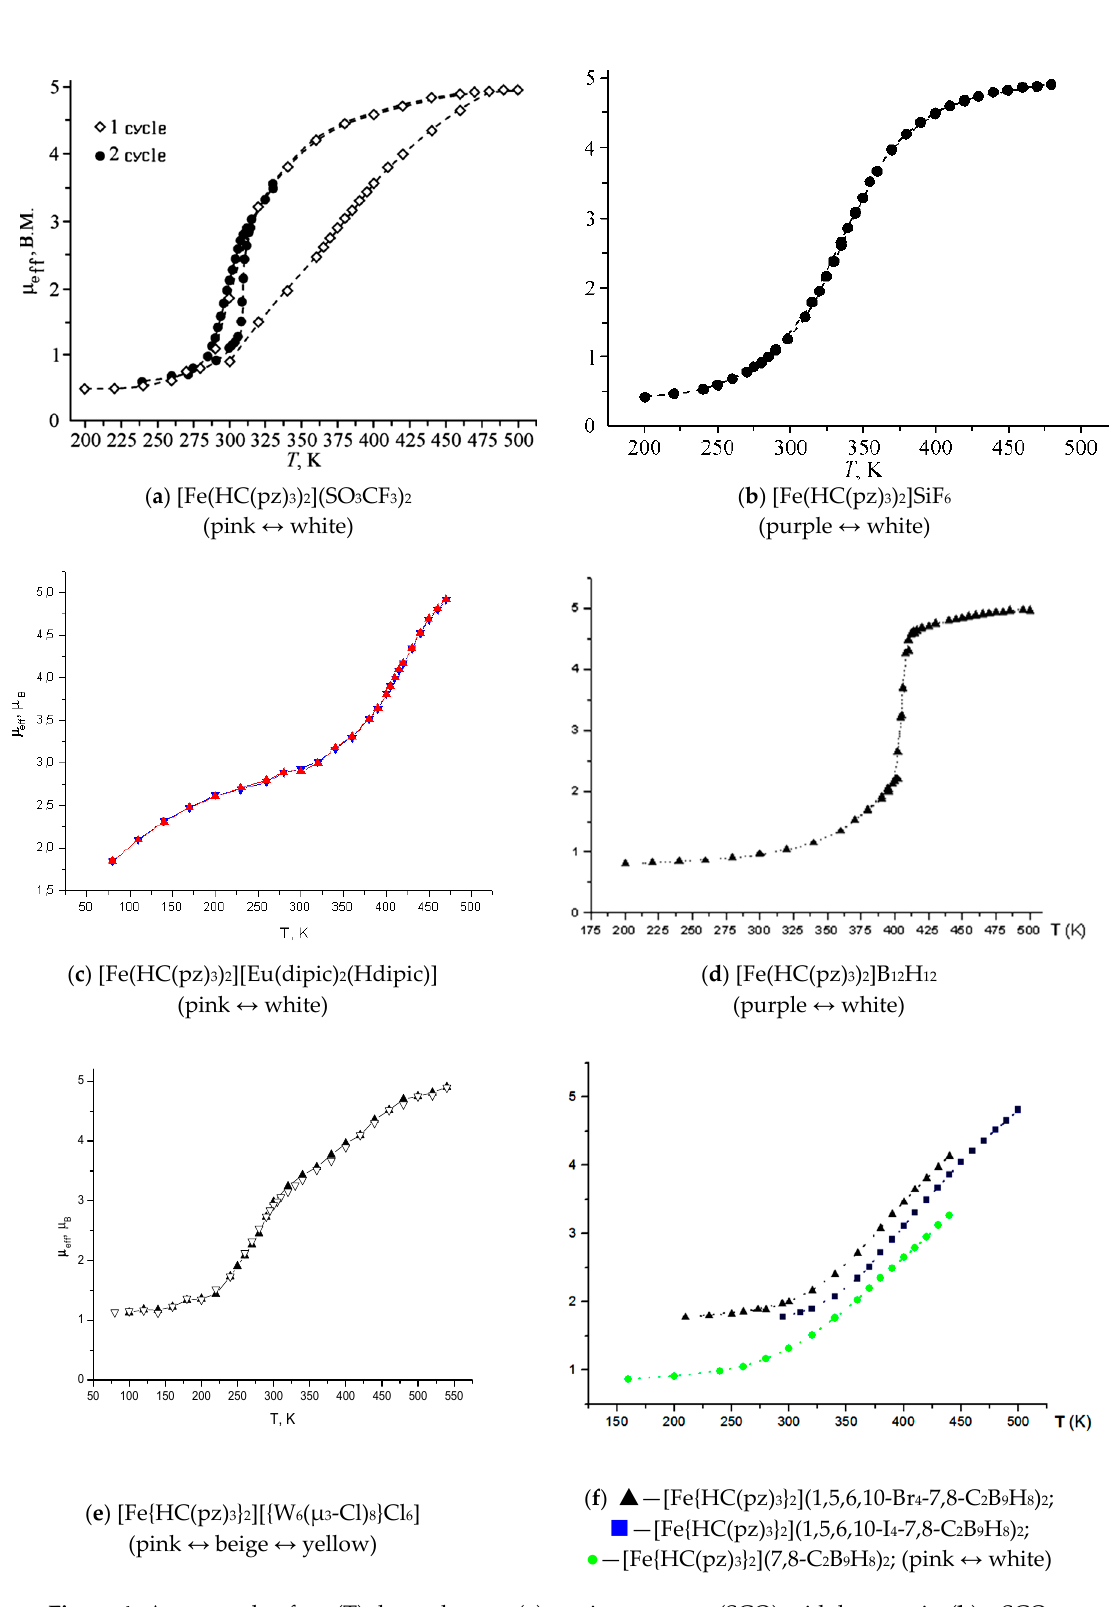
Figure 4. An example of μ eff (T) dependences: ( a )—spin crossover (SCO) with hysteresis; ( b )—SCO without hysteresis; ( c )—incomplete SCO with exchange interactions between metal ions of an antiferromagnetic nature; ( d )—complete and sharp SCO; ( e )—two stage SCO; ( f )—incomplete and continuous SCO.